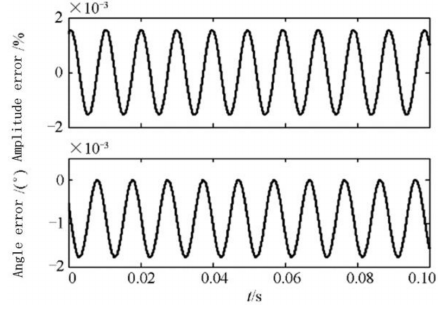
Figure 6. Phasor measurement error under the condition of off-nominal